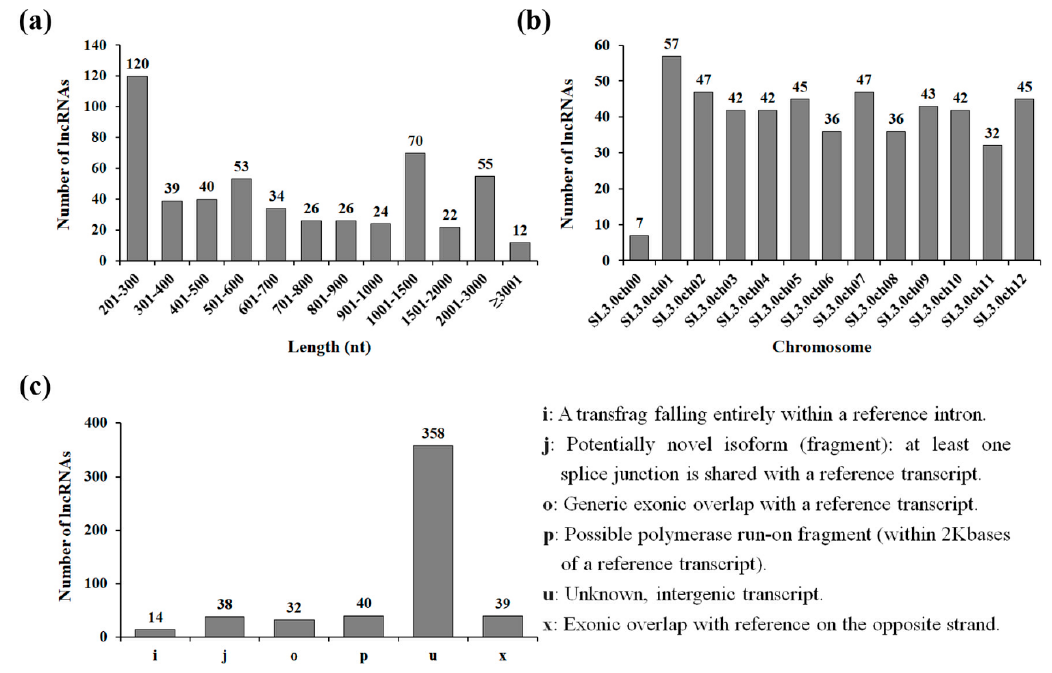
Figure 1. Characteristics of drought-responsive tomato long non-coding RNAs (lncRNAs). ( a ) Length distribution of lncRNAs. ( b ) Chromosome-wise distribution of long intergenic non-coding RNAs (lincRNAs). ( c ) Classification of lincRNAs.